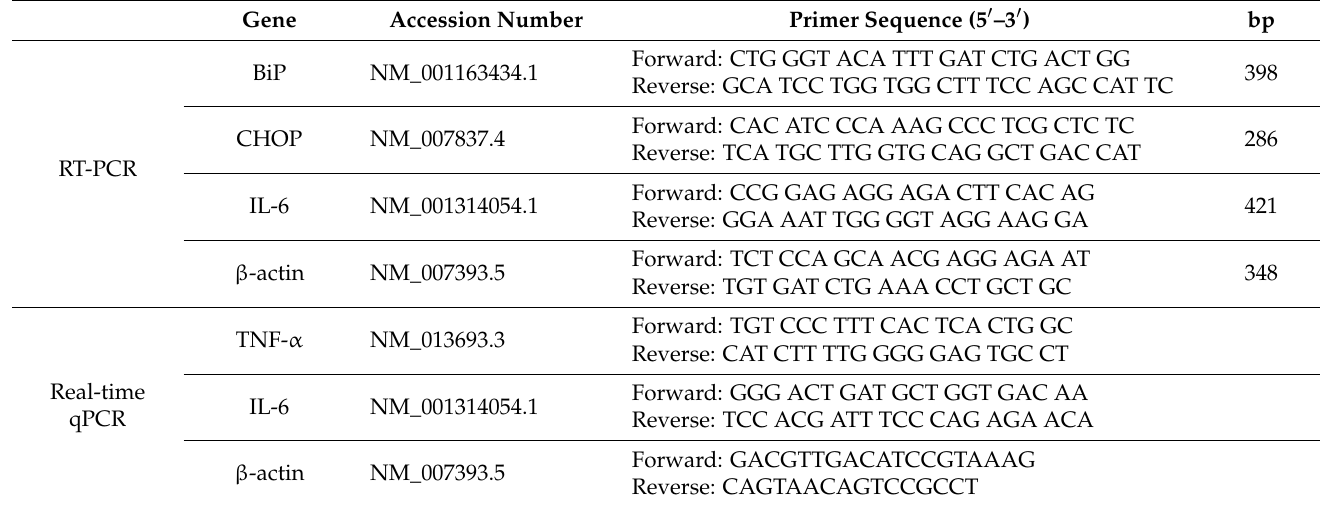
Table 2. Mouse primer sequences used in reverse transcription PCR, real-time qPCR.